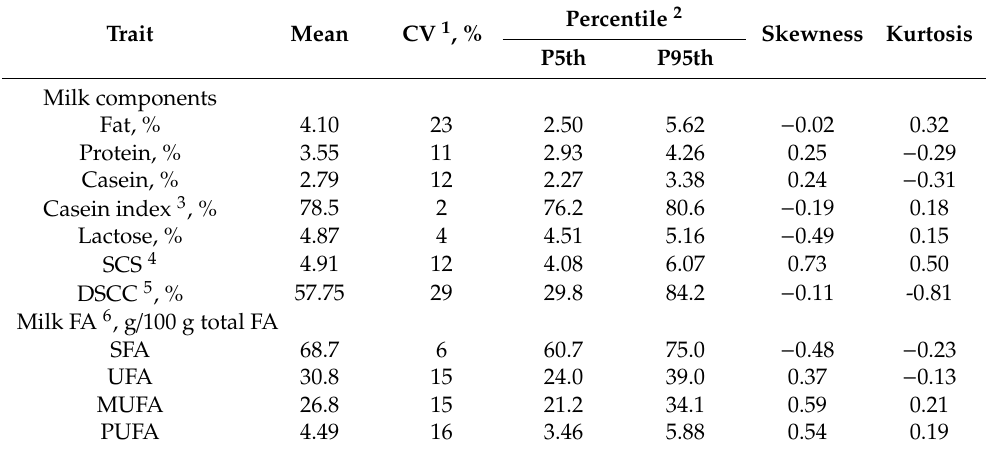
Table 2. Descriptive statistics of milk components and groups of fatty acids (FA) of individual milk